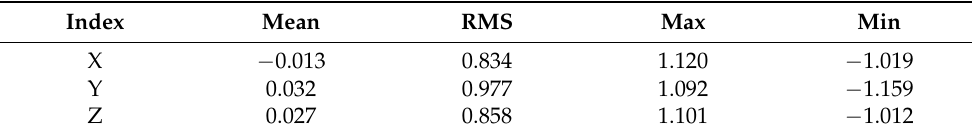
Table 12. Geometric calibration accuracy of TH-1 HR camera. (Unit: